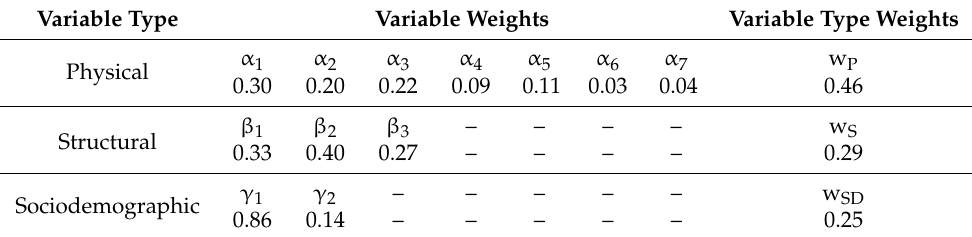
Table 11. Weights for each variable.